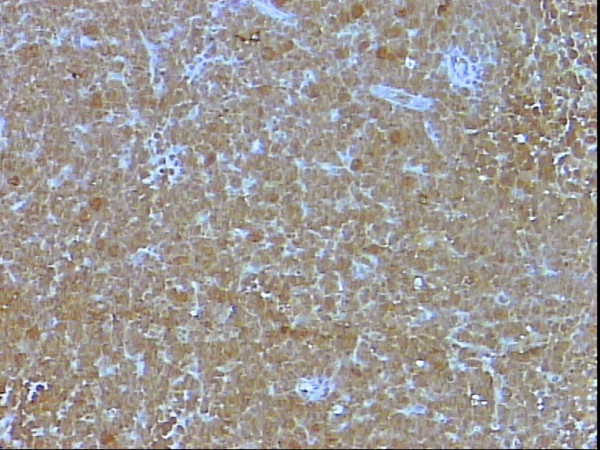
Nuclear staining of s100p of all neoplastic lymphocytes, DAB, Hx, × 10.